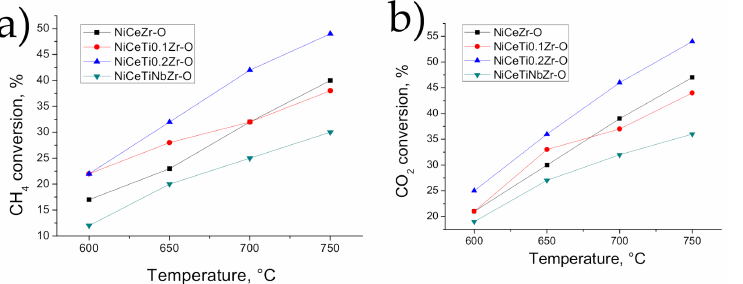
Figure 9. The dependences of ( a ) CH 4 conversion and ( b ) CO 2 conversion on temperature for one-pot